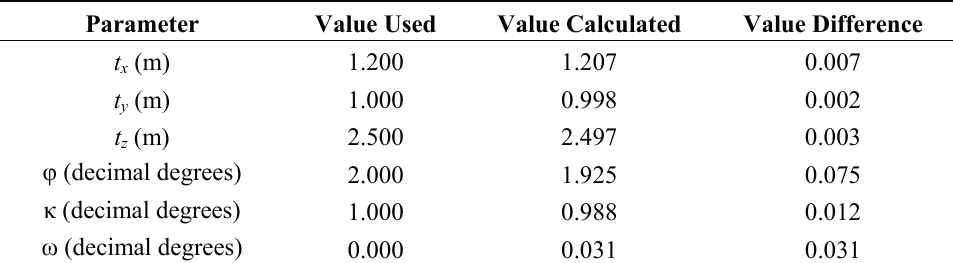
Table 2. Statistical numerical values of the Iterative Closest Point (ICP) process on point clouds (covering approximately 100 m 2